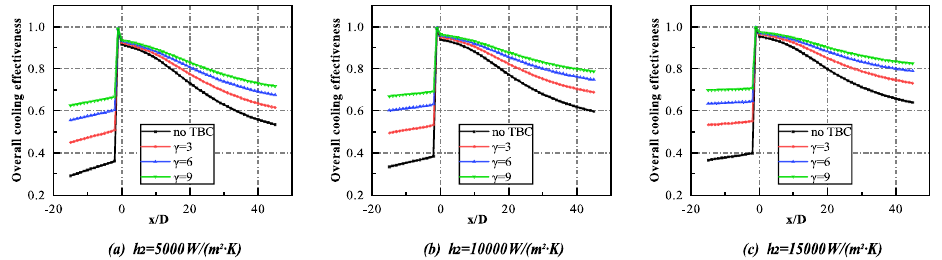
Figure 11. Effect of γ on 𝜂 at different h 2 under M = 0.375.